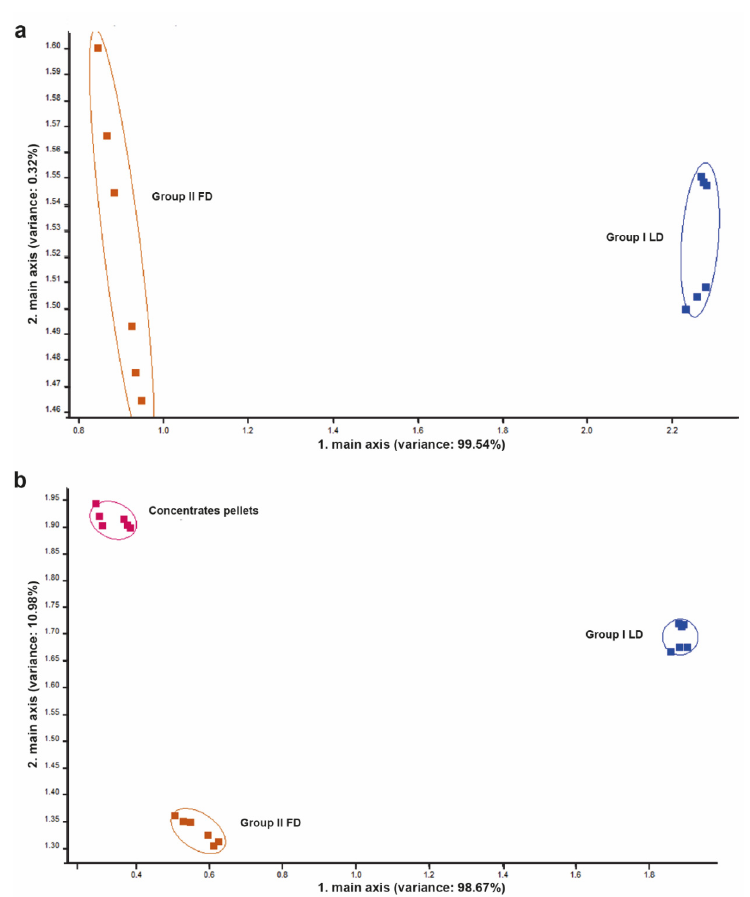
Figure 5. PCA for feed headspace. ( a ) PCA for lactational diet (LD) in group I and for far-off diet (FD) in group II. Note the high discrimination between the two types of feed. ( b ) PCA for LD in group I, for FD in group II and pellet concentrates. Note the high discrimination between the three samples. The numbers in parentheses indicate the percentages of the data matrix described by the relevant components and functions.